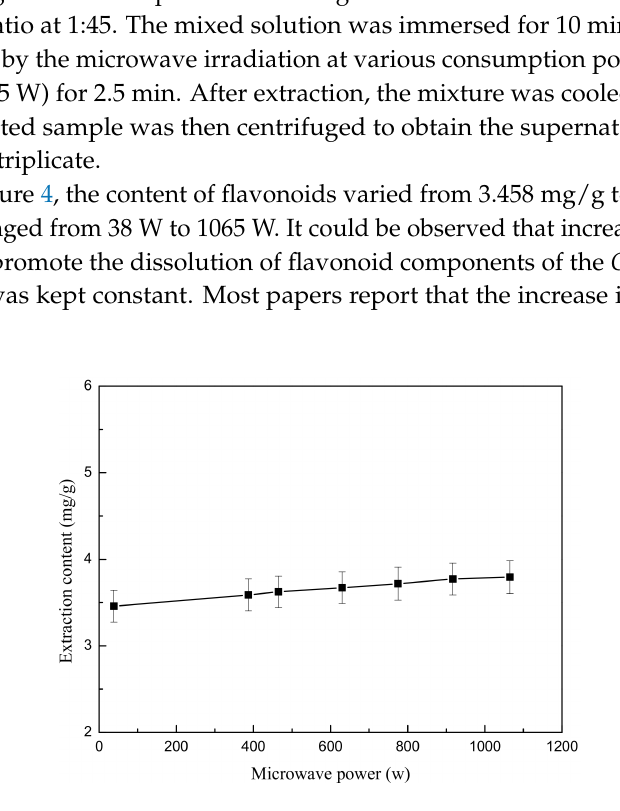
Figure 4. Effect of microwave power on extraction